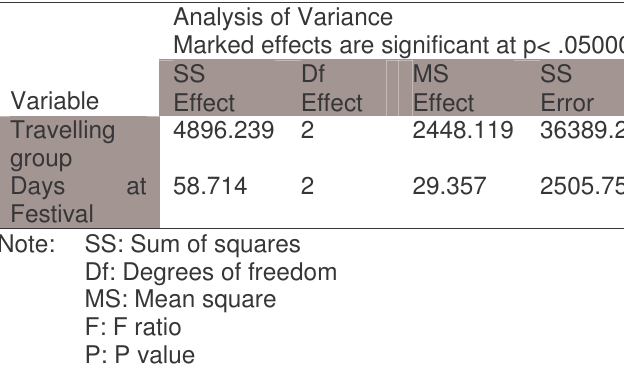
Table 6: ANOVA table Analysis of Variance